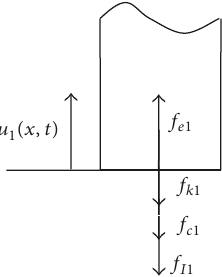
Figure 6: Force analysis of the lower end of oil tube.